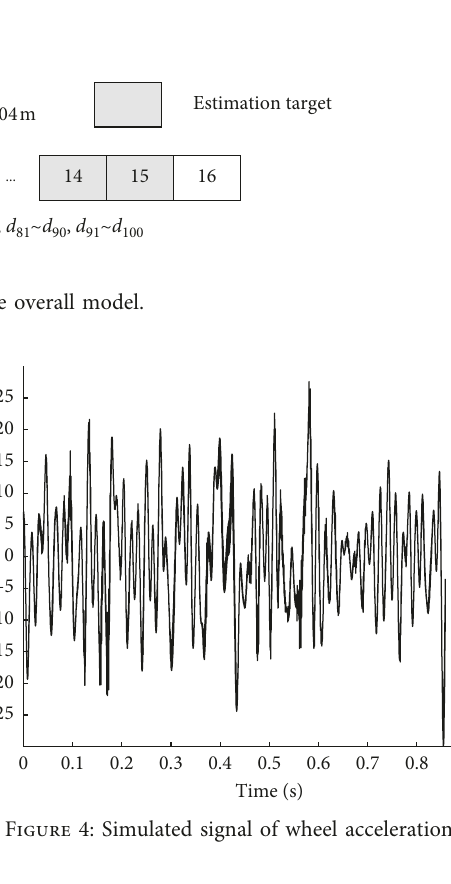
Figure 2: CA mortar disengagement model: (a) longitudinal view; (b) lateral view.